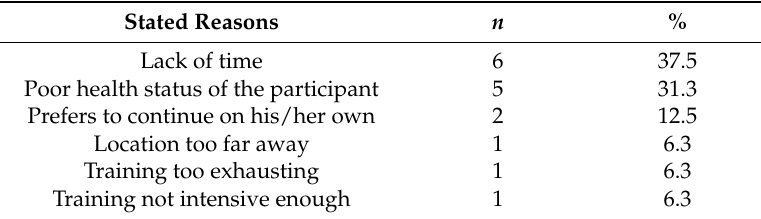
Table 3. Reasons for drop-out before the 75% attendance level ( n =